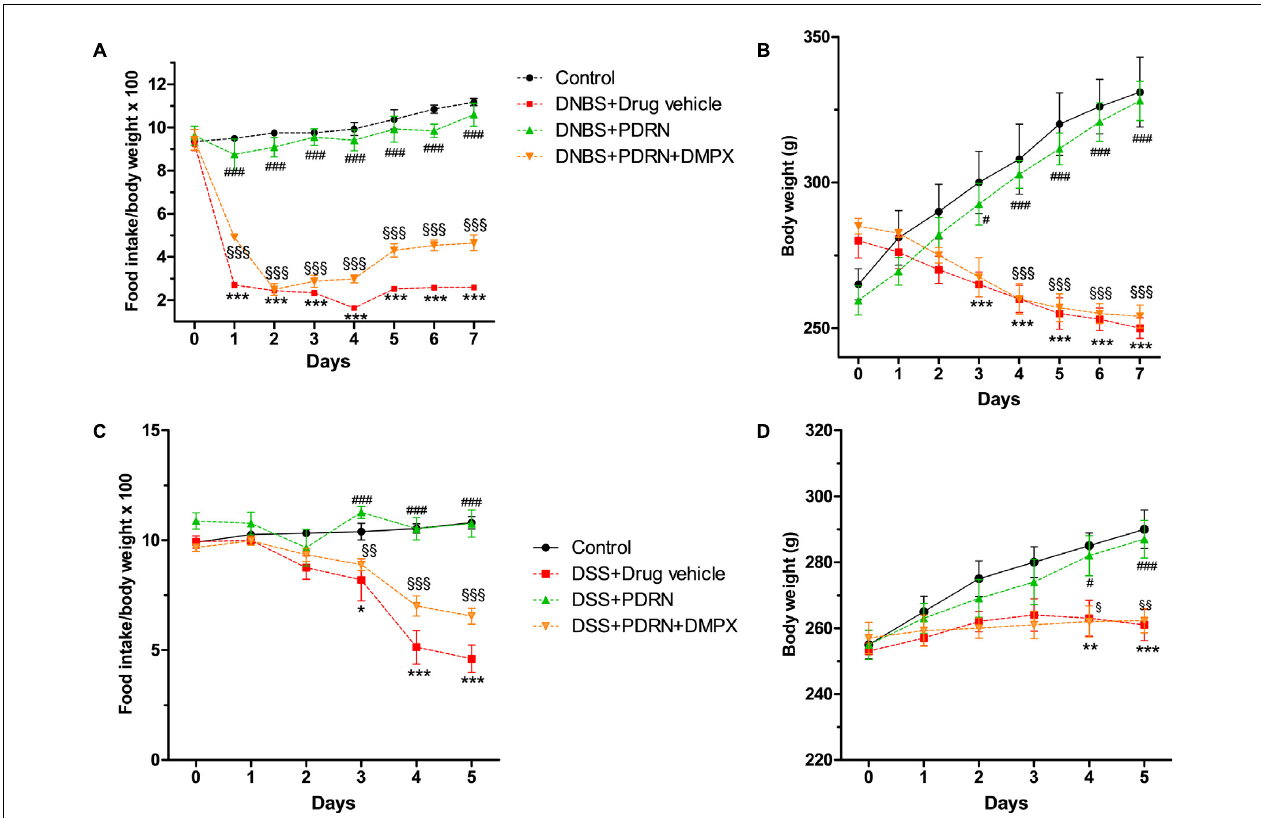
FIGURE 1 | Clinical evaluations. Food intake in DNBS-treated animals (A) , weight loss in DNBS-treated animals (B) , food intake in DSS-treated animals (C) , and weight loss in DSS-treated animals (D) was recorded. Values were obtained from seven animals per group and are expressed as means and SEM. ∗ p < 0.01, ∗∗ p < 0.001, ∗∗∗ p < 0.0001 vs control group; # p < 0.01, ### p < 0.0001 vs DNBS/DSS + drug vehicle group; § p < 0.01, §§ p < 0.001, §§§ p < 0.0001 vs DNBS/DSS + PDRN